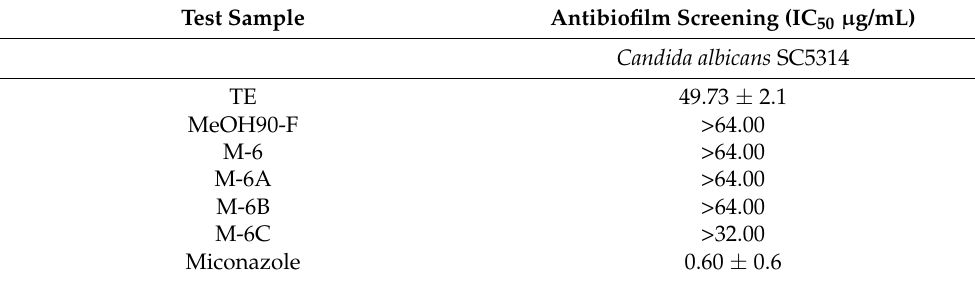
Table 6. In vitro antibiofilm activity of the total extract and fractions from C. cowellii leaves. Test